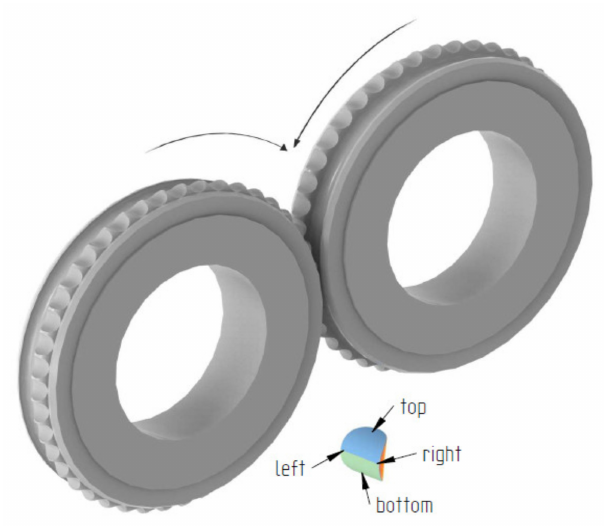
Figure 2. Forming rings used in roller press with marked rotation